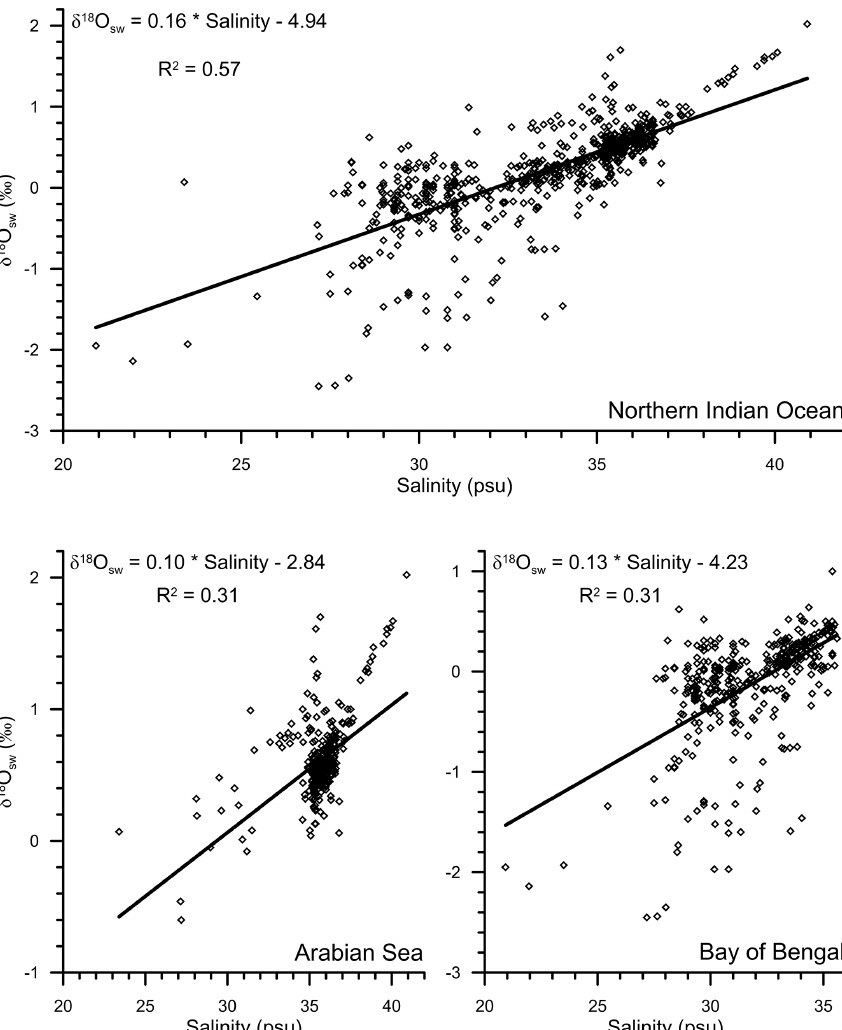
Figure 9. The relationship between the surface water oxygen isotopic ratio and salinity in the northern Indian Ocean (5 ◦ S–30 ◦ N), Arabian Sea, and the Bay of Bengal. The data points are from Schmidt et al. (1999), Delaygue et al. (2001), Singh et al. (2010), and Achyuthan et al.